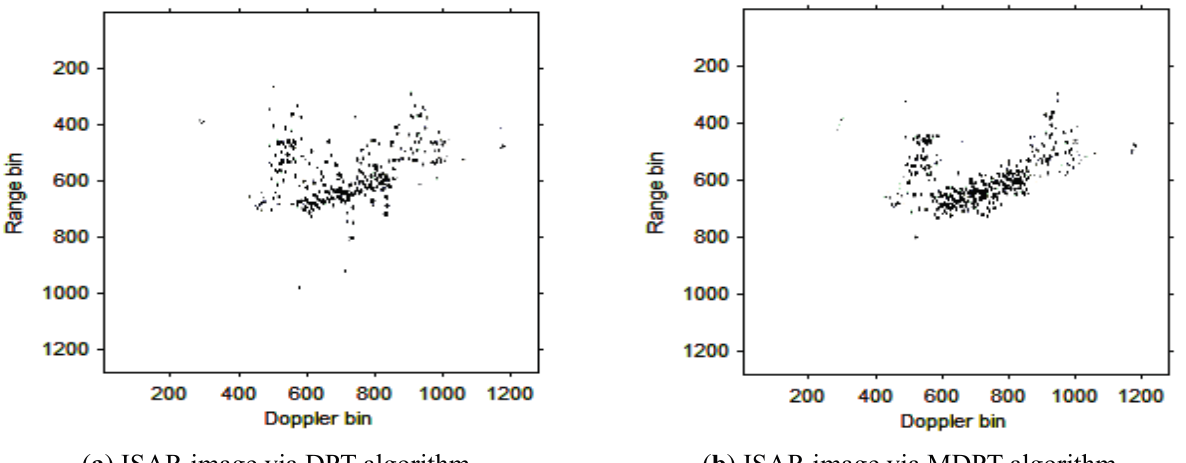
Figure 16. ISAR images at time t = 0.64 s based on DPT and MDPT algorithms.